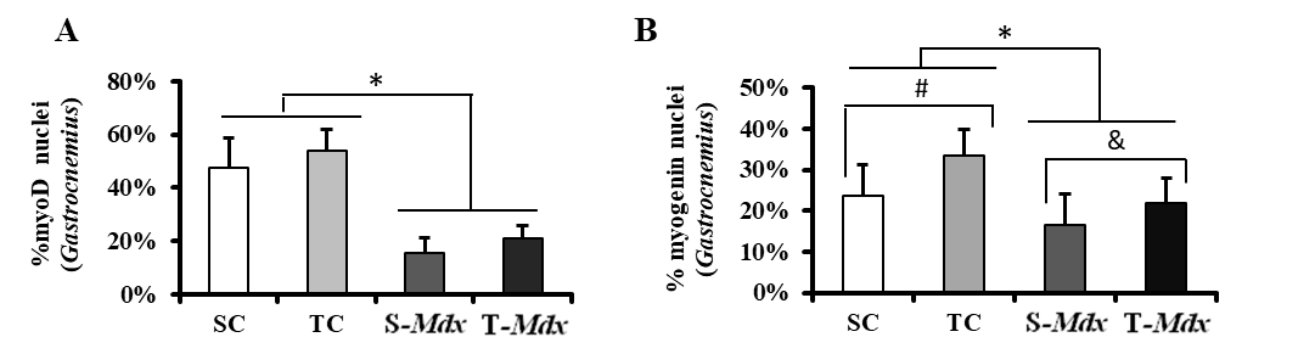
Figure - 4 Both, myoD (A) and myogenin (B) graphs show the percentage of immunoreactive nuclei (Mean + S.D.). In (A), the percentage of myoD immunoreactive nuclei in Mdx groups were lower than C groups (*=p<0.05). In (B), the percentage of myogenin immunoreactive nuclei in Mdx groups were lower than C groups (*=p<0.05). In addition, TC was higher than SC group (#=p<0.05) and T-Mdx was higher than S-Mdx group (&=p<0.05).